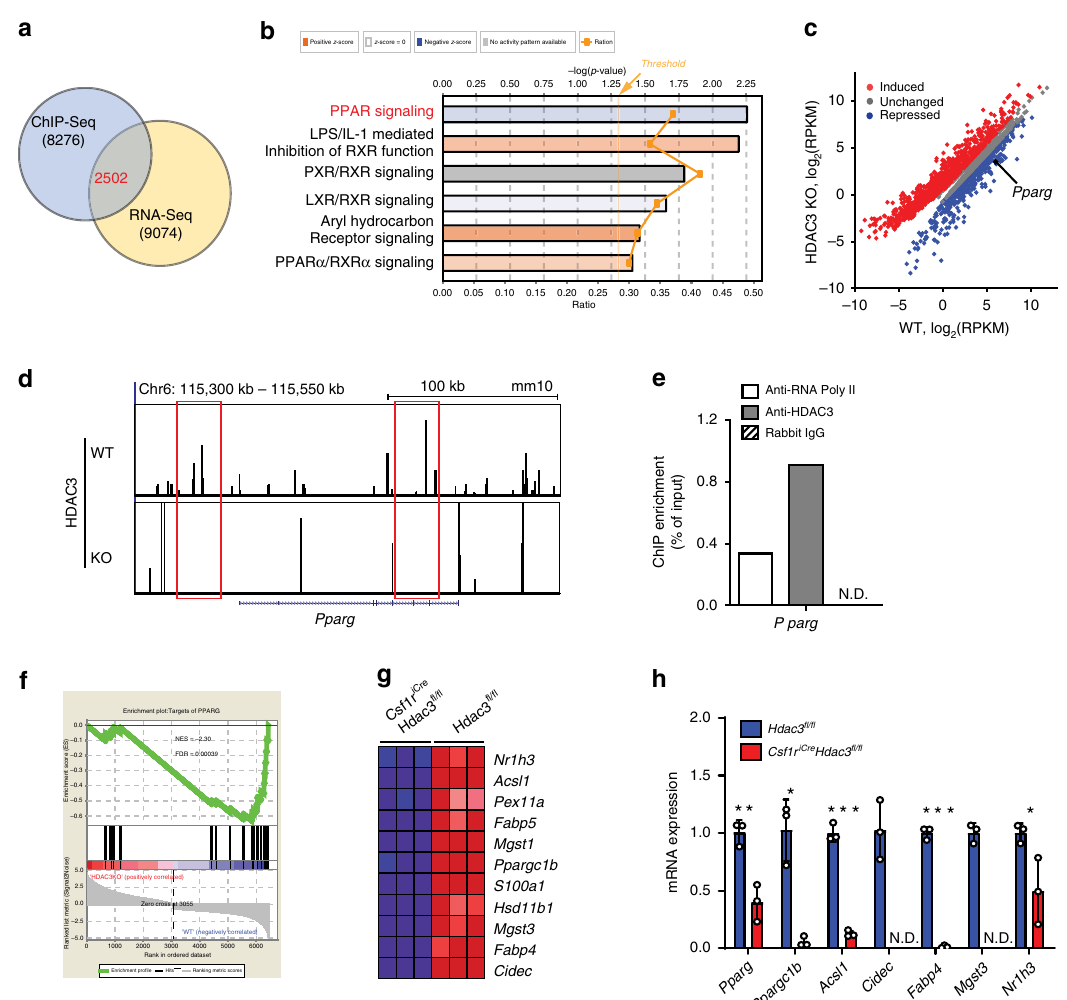
Fig. 6 HDAC3 de fi ciency leads to impaired PPAR- γ signaling in AM development. a Venn diagram of genes identi fi ed by HDAC3 ChIP-seq in the AMs from Hdac3 fl / fl adult mice overlapped with differentially expressed genes from bulk RNA-seq. b Ingenuity Pathway Analysis (IPA) showing canonical nuclear receptor pathways of the overlapped genes as in a . Threshold indicates the minimum signi fi cance level by the right-tailed Fisher ’ s exact test. Ratio refers to the number of molecules from the dataset that map to the pathway listed divided by the total number of molecules that map to the canonical pathway from within the IPA knowledgebase. c Scatter plot of bulk RNA-seq data showing the overlapped genes as in a from n = 3 Hdac3 fl / fl WT; Csf1r iCre Hdac3 fl / fl KO littermates. Fold change >1.5 up (red) or down (blue) and false discovery rate (FDR) < 0.05. RPKM, reads per kilobase per million. d Genome browser tracks of the Pparg locus highlighting ChIP-seq data at the enhancers (boxed). Hdac3 fl / fl , WT; Csf1r iCre Hdac3 fl / fl , KO. e ChIP-qPCR data representing HDAC3 binding at the Pparg enhancers in MH-S cells. Enrichment value is normalized to input measurements. Representative data from two independent experiments. f GSEA plot of targets of PPAR- γ from bulk RNA-seq. g Heat map representing downregulated genes related to PPAR- γ signaling identi fi ed by GSEA as in f . Colors (red to blue) show expression values (high to low). h qPCR analysis of mRNA expression levels of the genes associated with PPAR- γ signaling. n = 3 Hdac3 fl / fl ; Csf1r iCre Hdac3 fl / fl . * P = 0.043 ( Nr1h3 ); ** P = 5.5e − 3 ( Pparg ), 3.4e − 3 ( Ppargc1b ); *** P = 4.9e − 5 ( Acsl1 ), 6.4e – 6 ( Fabp4 ) by the Student ’ s two-tailed unpaired t test. Bars represent mean ± SD of biologically-independent samples in each panel. Source data are provided as a Source Data fi